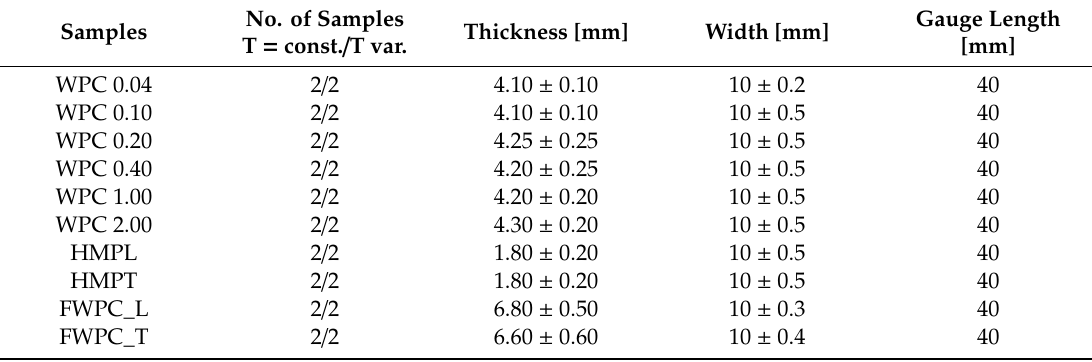
Table 3. The physical characteristics of the samples for the DMA test (Legend: DMA operated under constant temperature T = const.; DMA operated under temperature variation